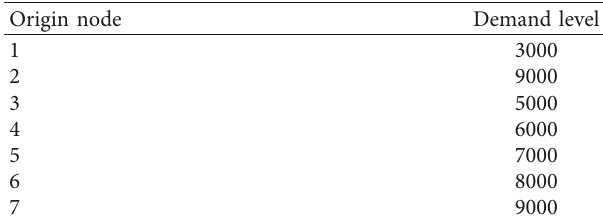
Table 2: Demand from each residential zone to be evacuated.